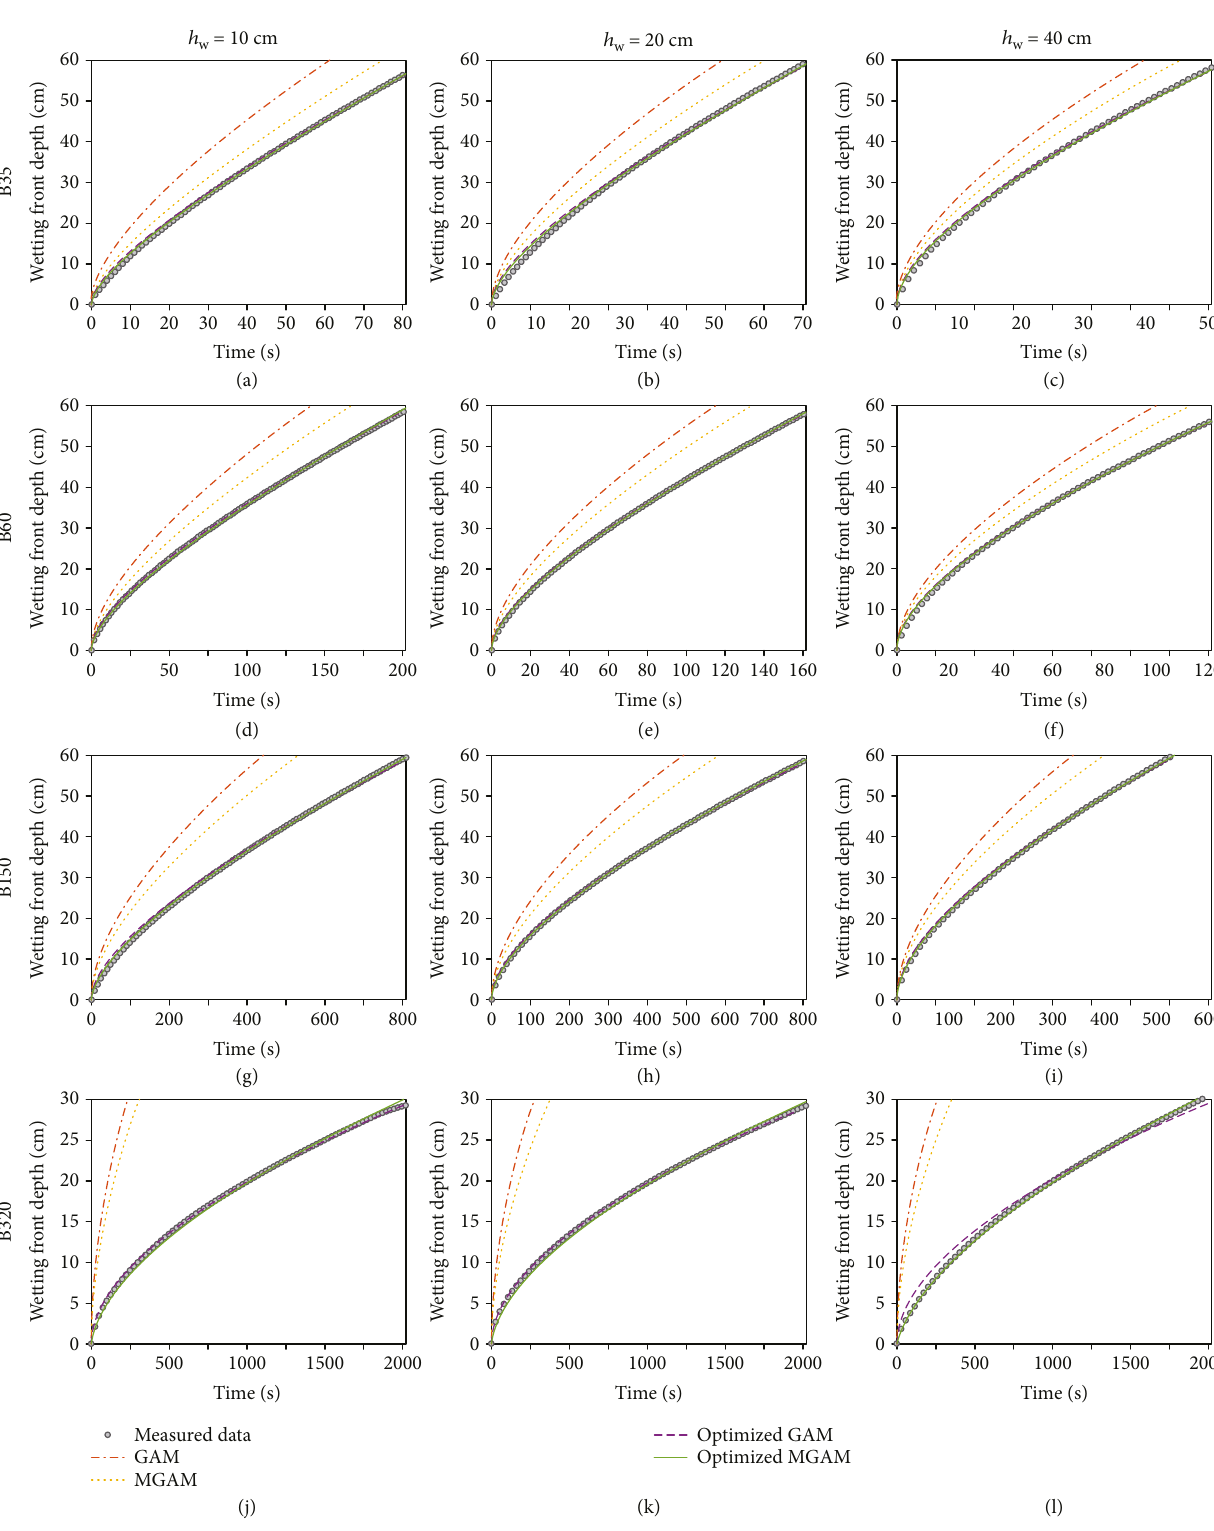
Figure 6: In fi ltration simulation of GAM and MGAM of sands B35, B60, B150, and